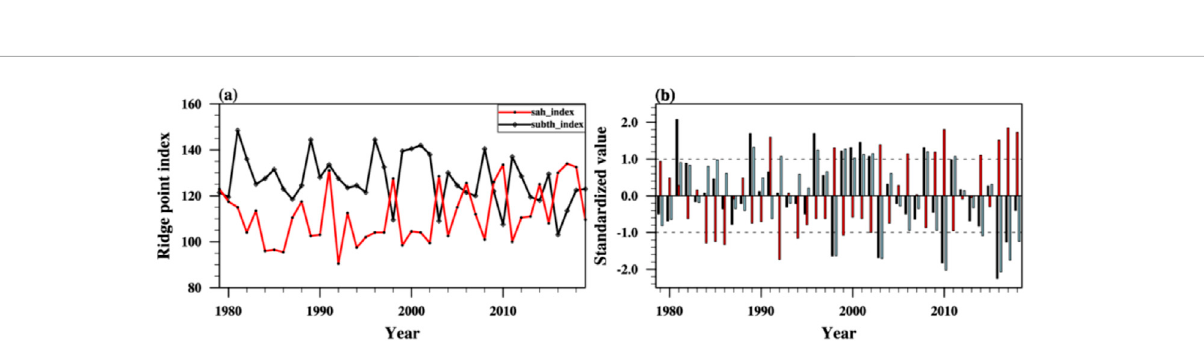
Transportofthecolumn-integratedwatervapor(unit:kg · m − 1 · s − 1 )andwatervapor fl uxdivergence(unit:10 − 5 g · cm − 2 · hPa − 1 · s − 1 )indifferentphaseyears of the spring SH ( (A,B) represent years of positive and negative SH, respectively) and the Niño-3 index anomalies ( (C,D) represent years of El Niño and La Niña, respectively) under negative PDO phase. The solid black lines 1254 and 588 dgpm represent the characteristic lines of 200 hPa SAH and 500 hPa WPSH respectively; the yellow dotted line indicates the statistical mean position of the two high pressure system.